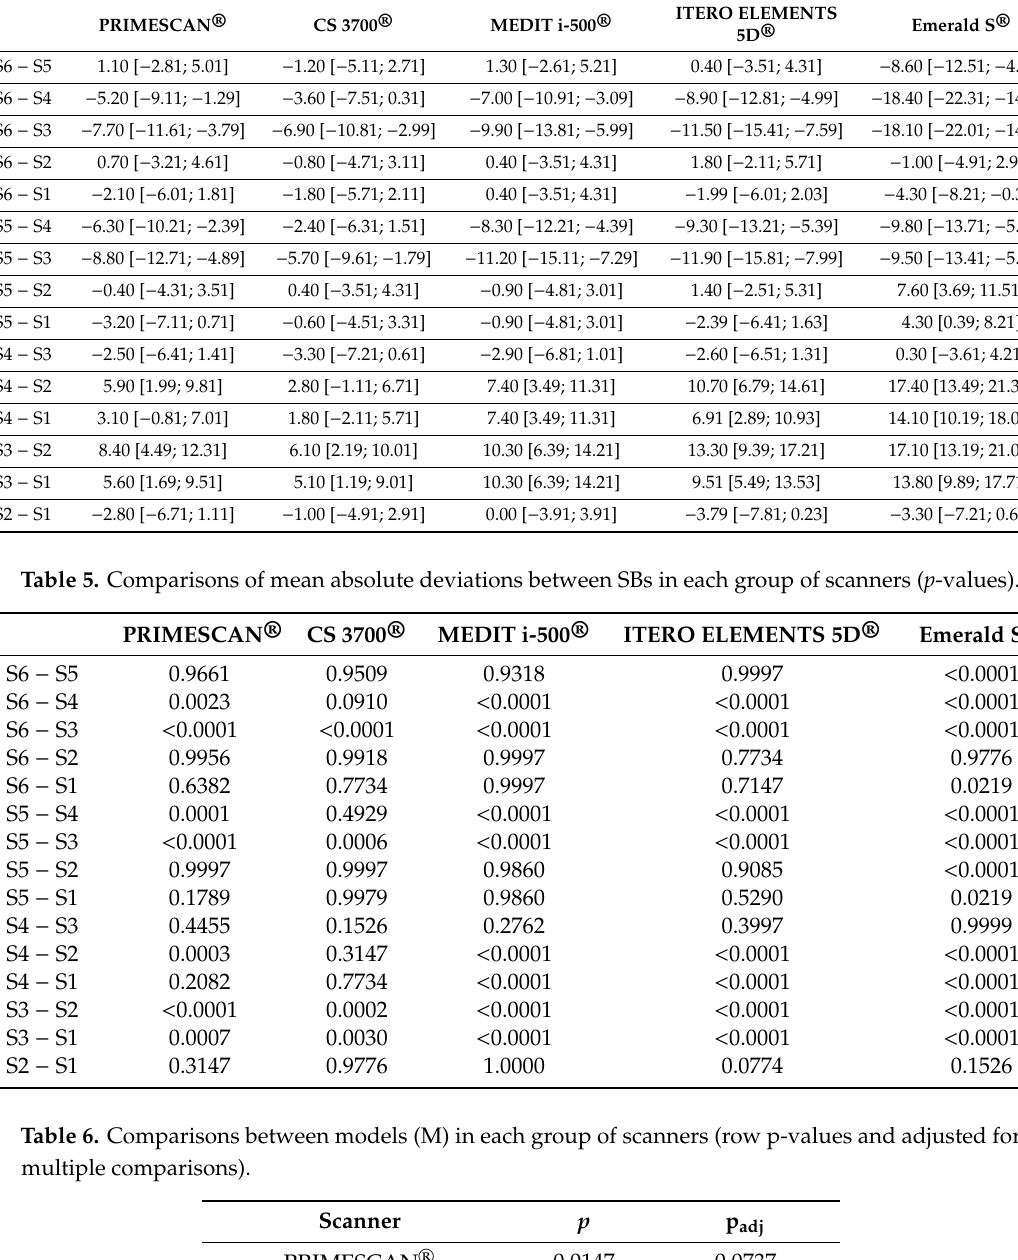
Table 4. Comparisons of mean absolute deviations between SBs in each group of IOSs (mean di ff erences and 95% CIs for them).